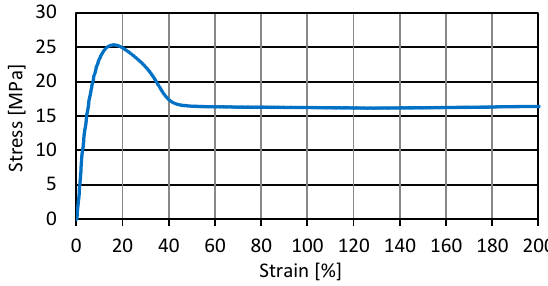
Figure 4. Diagram of the relationship between tensile strength and elongation of a high-density polyethylene pipe (HD-PE).